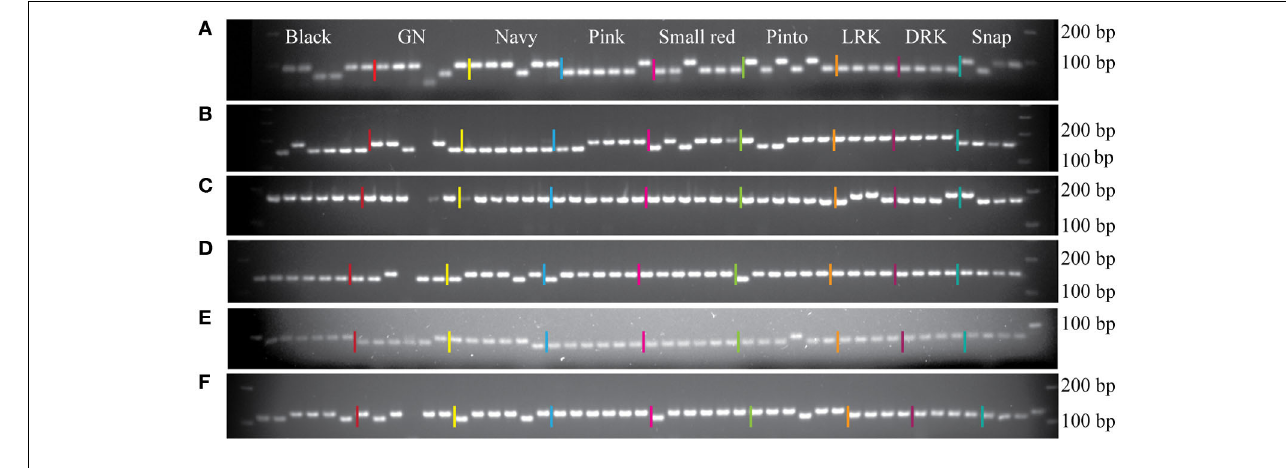
FIGURE 3 | Six InDel markers tested on random genotypes from nine different market classes. The names of the genotypes, from left to right, are listed in Table 2 . (A) Marker NDSU_IND_07_02.6485 from pinto market class. (B) Marker NDSU_IND_10_42.1355 from pinto market class. (C) Marker Table 7 | Specifications of 24 pinto